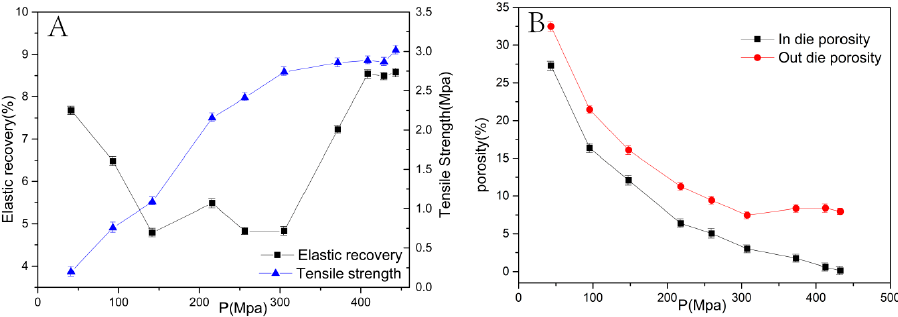
Figure 7. The effect of compaction pressure on elastic recovery, tensile strength ( A ), and porosity ( B ).